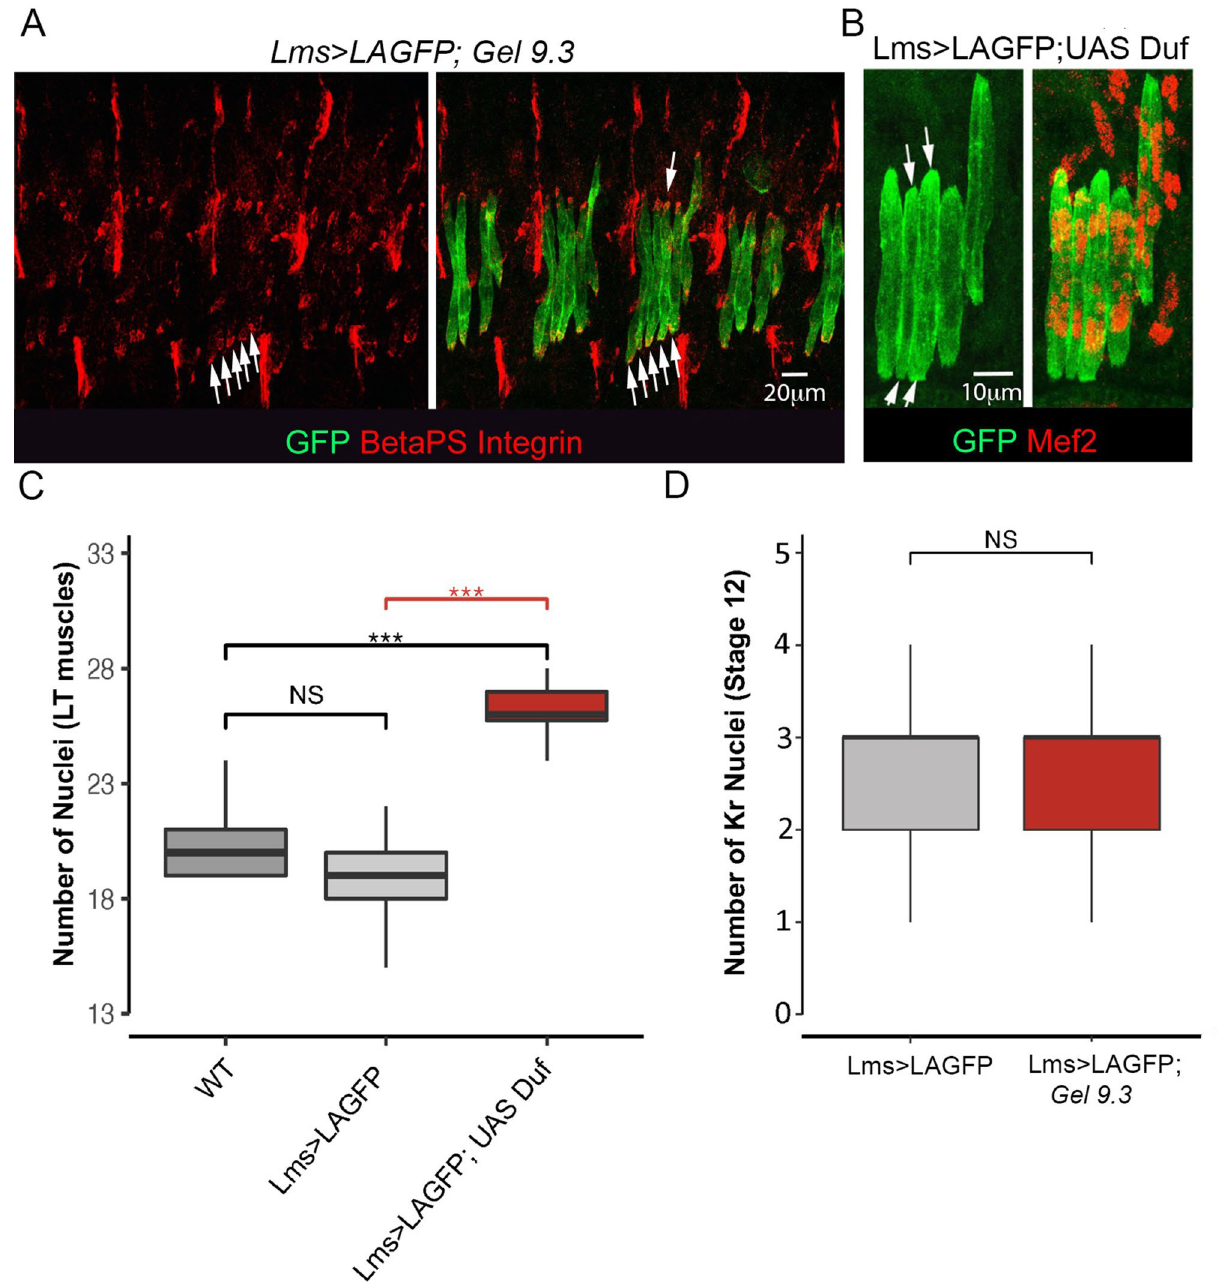
Figure 5. Split LT fibers keep LT properties but do not arise from an excess of progenitors and could be generated by local increase of myoblast fusion. ( A ) Splitting in Gel mutants is associated with accumulation of ßPS integrin (arrows) at termini of split LT fibres. ( B–C ) Duf overexpression mimics the Gel LT splitting phenotype (arrows in B ), which correlates with increased numbers of myonuclei. Myonuclei were counted ( C ) in 13 wild type abdominal segments and in 13 Lms > LAGFP > Duf abdominal segments with splitting events and in a larger number of abdominal segments ( n = 43) from Lms > LAGFP . A Wilcoxon-Mann–Whitney test was applied to assess statistical significance. *** p < 0.001. ( D ) Graphical representation of number of Kr progenitors at stage 12 showing that supernumerary LT muscle fibres are not due to an excess of LTs progenitors. A large number of hemisegments in Lms > LAGFP ( n = 150) and Gel 9.3;Lms > LAGFP mutant embryos ( n = 114) were analysed. A Wilcoxon-Mann–Whitney test was applied to assess statistical significance. *** p <